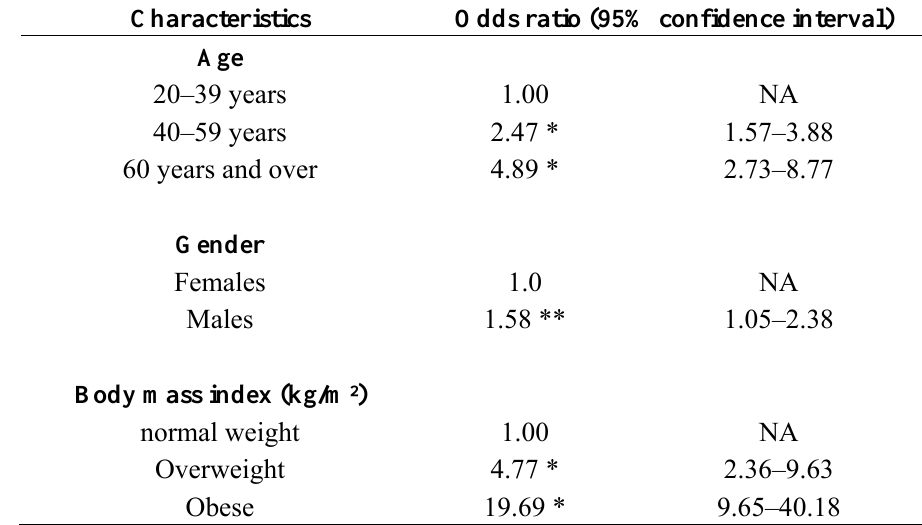
Table 3. Odds of Having MetS by Age, Gender and BMI status among Kuwaiti Adults Odds ratios for prevalence of metabolic syndrome among adults ≥ 20 years of